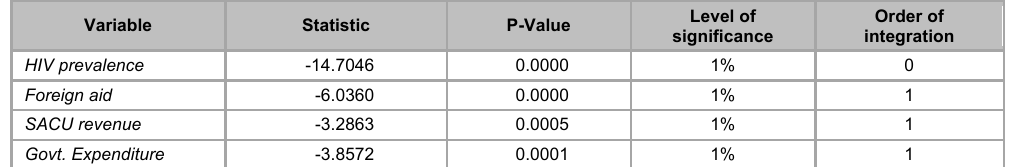
Im, Pesaran and Shin panel unit root test